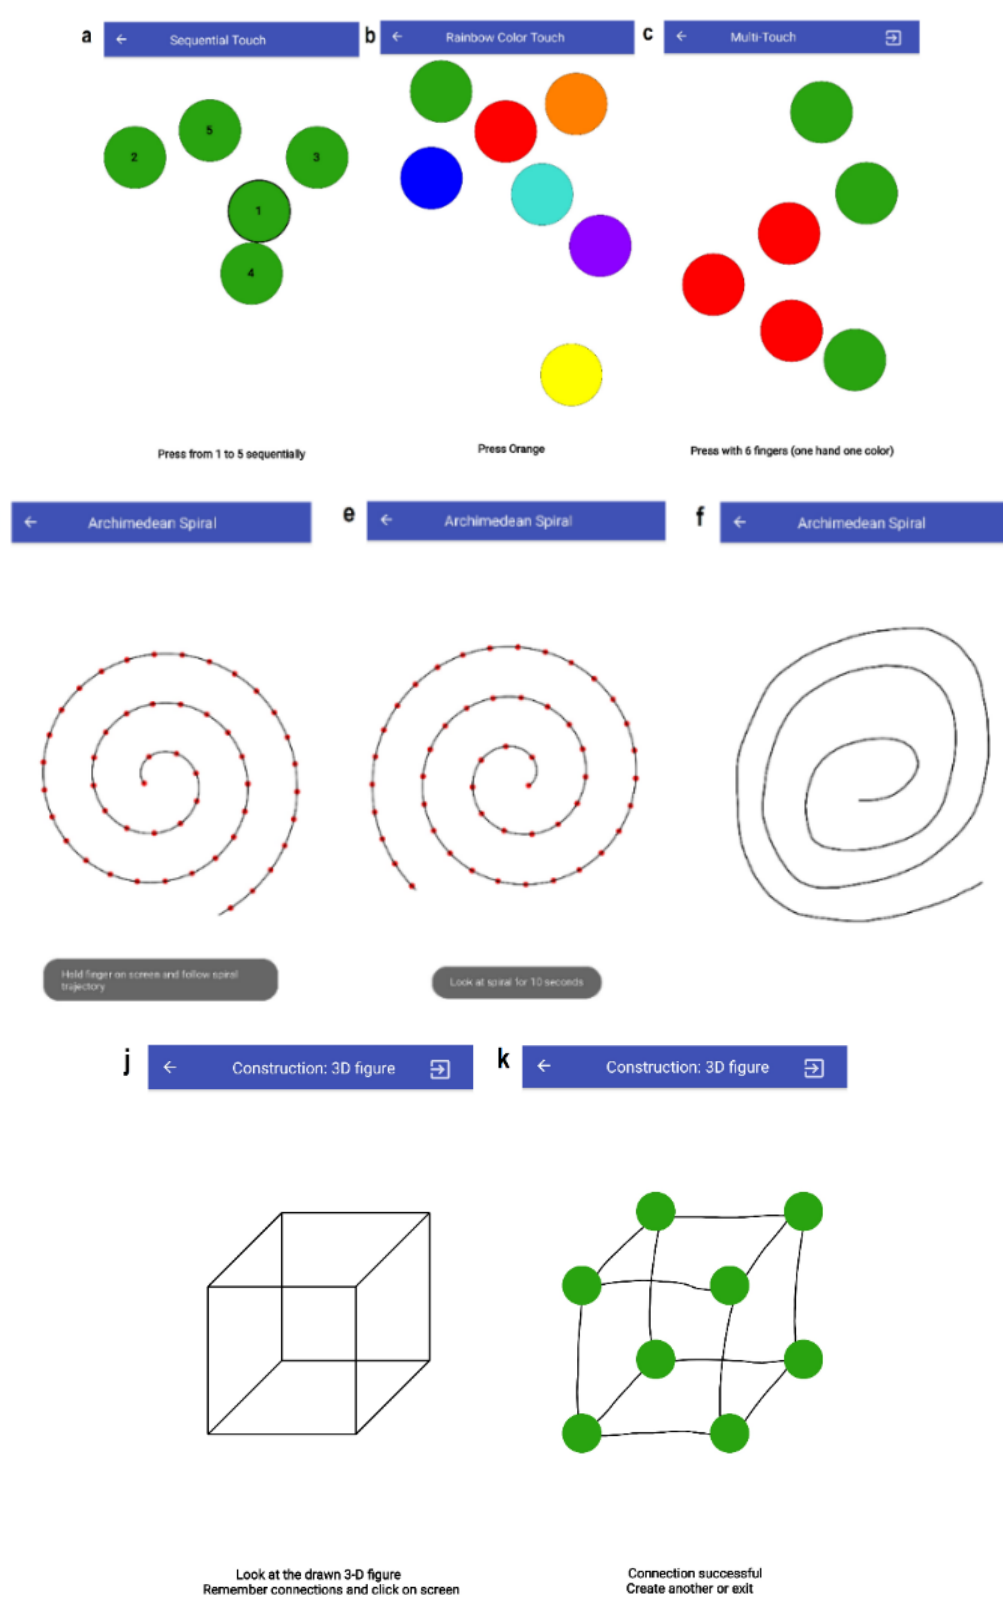
Figure 1. Screenshots of screening tasks: touches (( a ) — sequential; ( b ) — rainbow color; ( c ) — multi-touch); Archimedean spiral (( d ) — following contour clockwise; ( e ) — showing spiral counterclockwise; ( f ) — drawing contour counterclockwise); construction of 3D figure (( j ) — showing; ( k ) — constructing cube).